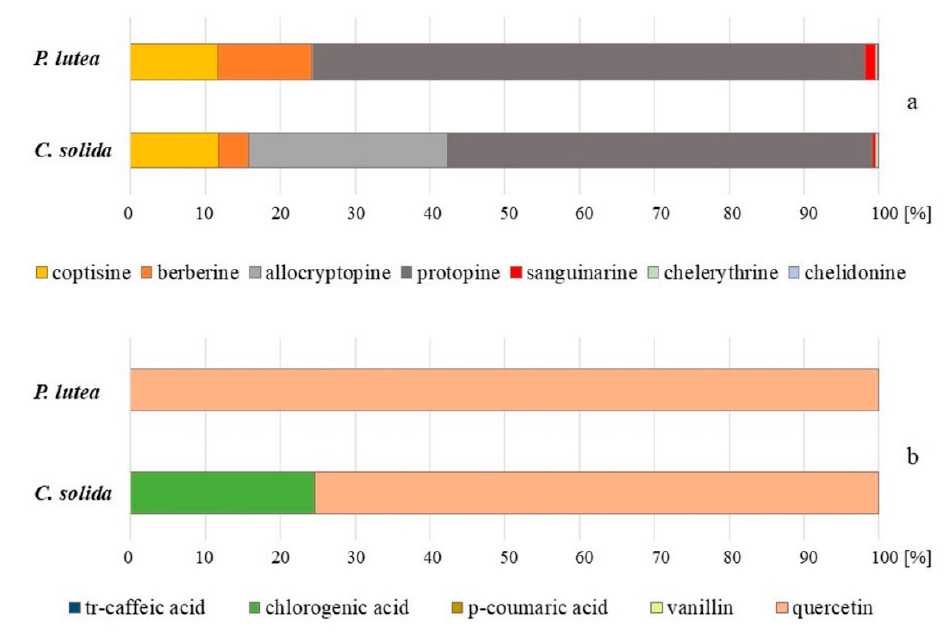
Figure 1. Isoquinoline alkaloids ( a ) and phenolic compounds ( b ) proportions in aerial parts of P. lutea and C. solida .